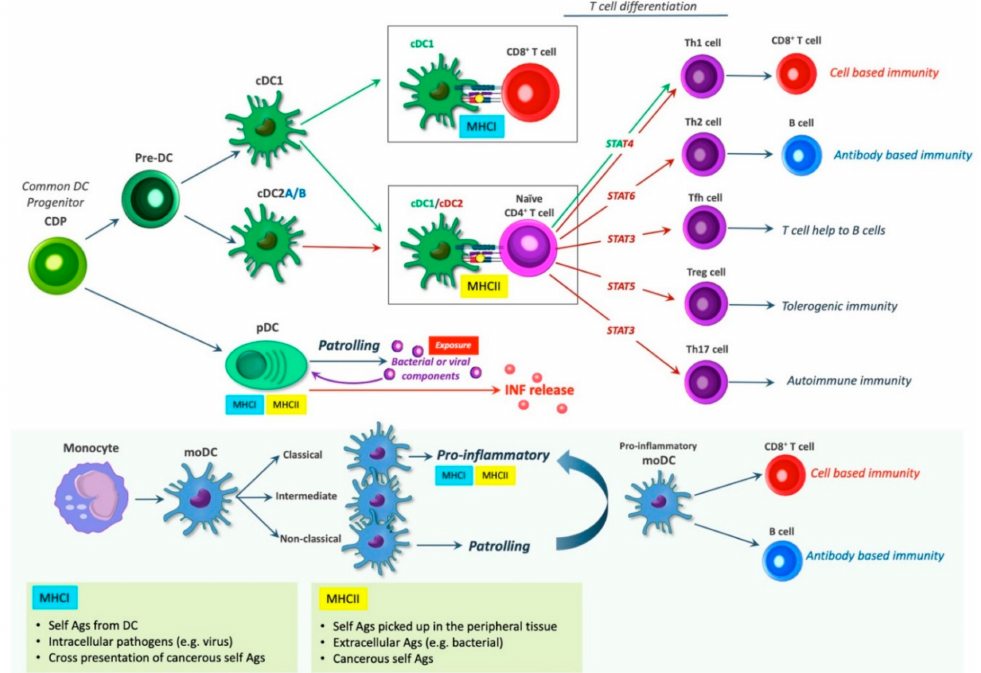
Figure 3. DC subsets and T-cell differentiation. Various DC types exist that partake in regulating immune reactions. Depending on the context, DCs may induce the activation of different T cell subsets. cDC1s can present Ags on MHCII to naïve CD4 + T cells to induce Th1 response or cross- present Ags on MHCI to cytotoxic CD8 + T cells, both resulting in cell-based immunity. In mice, cDC1s and cDC2s can induce Th1 cell and Th17 cell skewing, respectively, whereas human cDC2s can induce both Th1 cell and Th17 cell skewing [69]. cDC2s induces the T-cell differentiation of naïve CD4 + T cells through MHCII Ag presentation, giving rise to the T cell subsets: Th1, Th17, Th2, Tfh, and Treg, which induce cell-based immunity, autoimmune immunity, antibody based immunity, T cell help to B cells, and tolerogenic immunity, respectively. pDCs express both MHCI and MHCII and patrol the bloodstream and peripheral lymphoid organs. When exposed to viral and bacterial infections, pDCs produce type I interferon (IFN). MoDCs are divided into classical, intermediate and non-classical subsets, of which the classical seem to be pro-inflammatory, while the non-classical subset exerts patrolling functions. The pro-inflammatory moDCs induce cell based- and antibody-based immunity via CD8 + T cells and B cells,